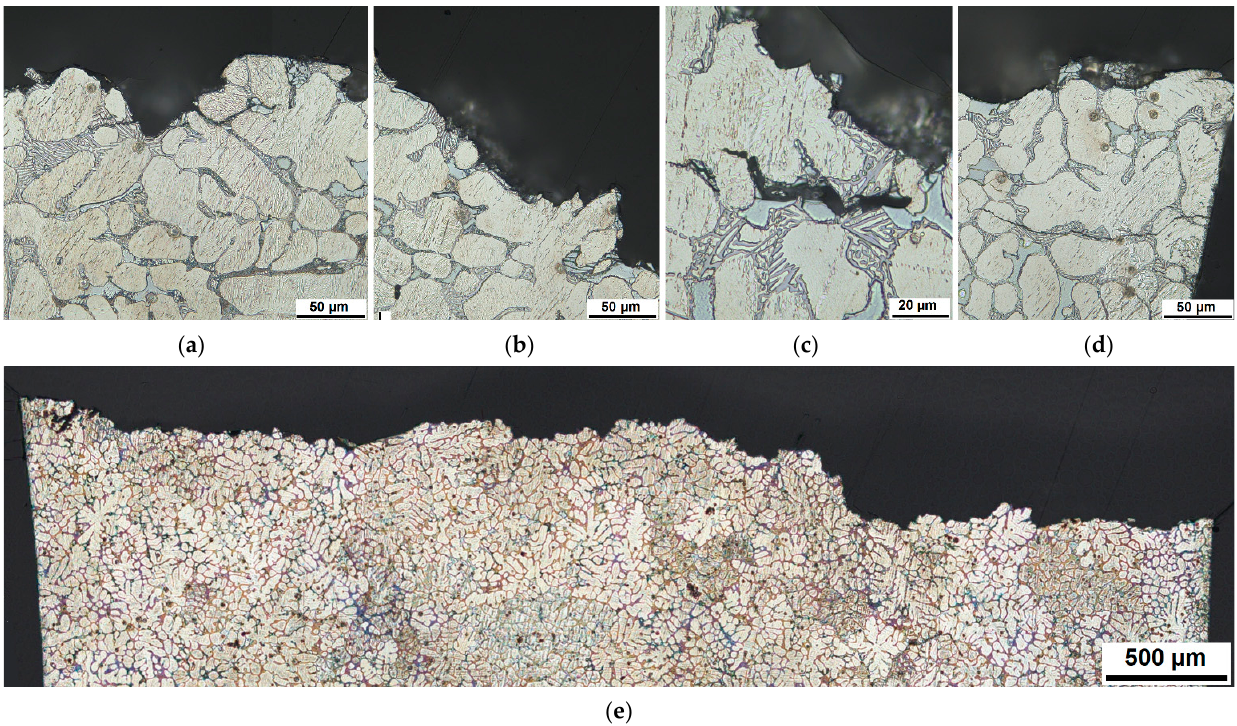
Figure 8. Cross-sectional micrographs of fracture surface after fatigue load (R = − 1, 12,000 cycles) showing the crack propagation of the sub-cracks near the main crack and its interaction with the microstructural features ( a – e ).